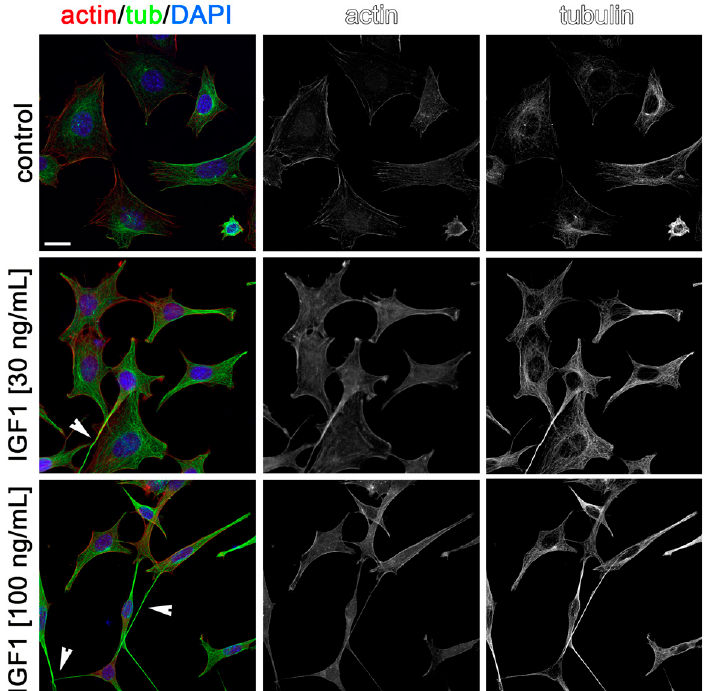
Figure 7. Insulin-like growth factor (IGF1) treatment alters GN11 cytoskeleton organization. GN11 cells treated with IGF1 (at 30 and 100 ng/mL) were immune-labeled for F-actin (red) and α -tubulin (green) to reveal microfilament and microtubule organization, respectively. Single channels are shown as black and white images. Arrowheads point at cells displaying a prominent fusiform morphology. Scale bar: 25 µm.